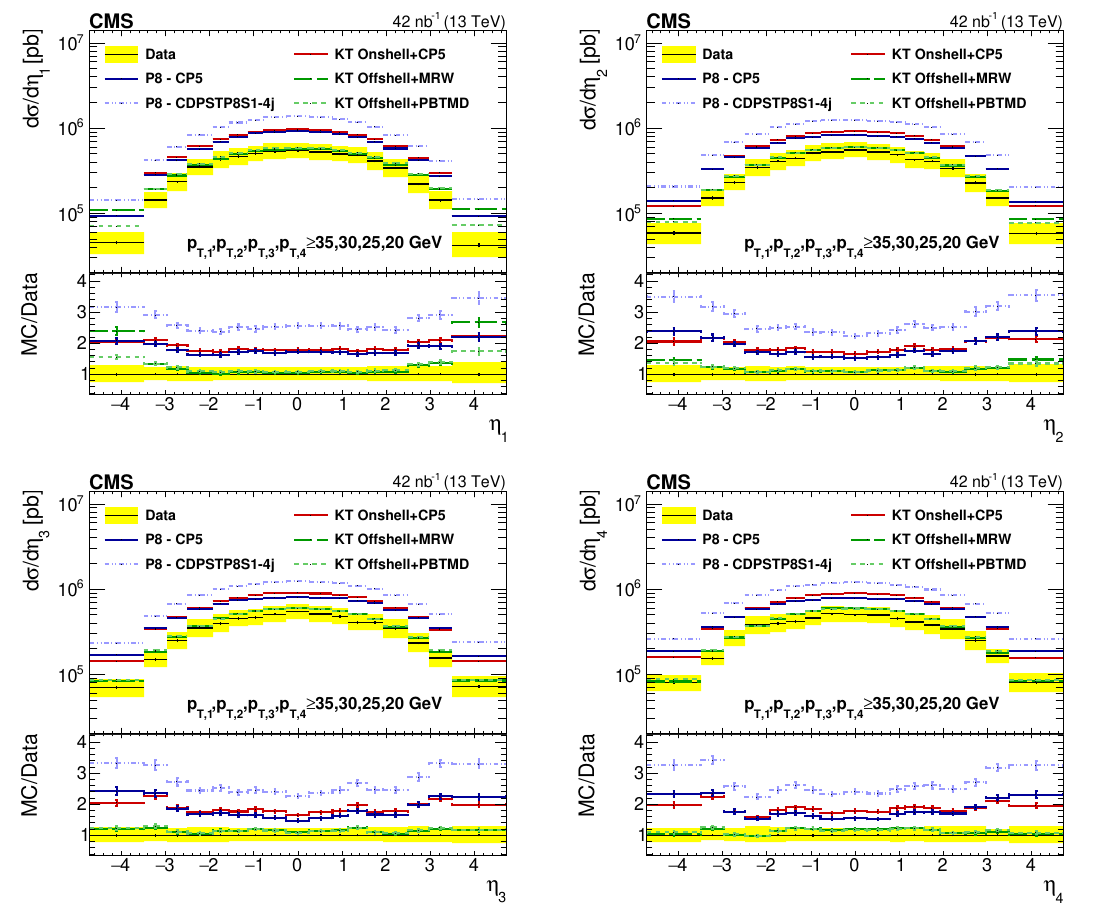
Figure 11 . Comparison of the unfolded η spectra of data with different SPS+DPS KaTie (KT) and pythia 8 (P8) models, for the leading (upper left), subleading (upper right), third leading (lower left), and fourth leading (lower right) jet in Region I. The error bars represent the statistical uncertainty, and the yellow band indicates the total (statistical+systematic) uncertainty in the